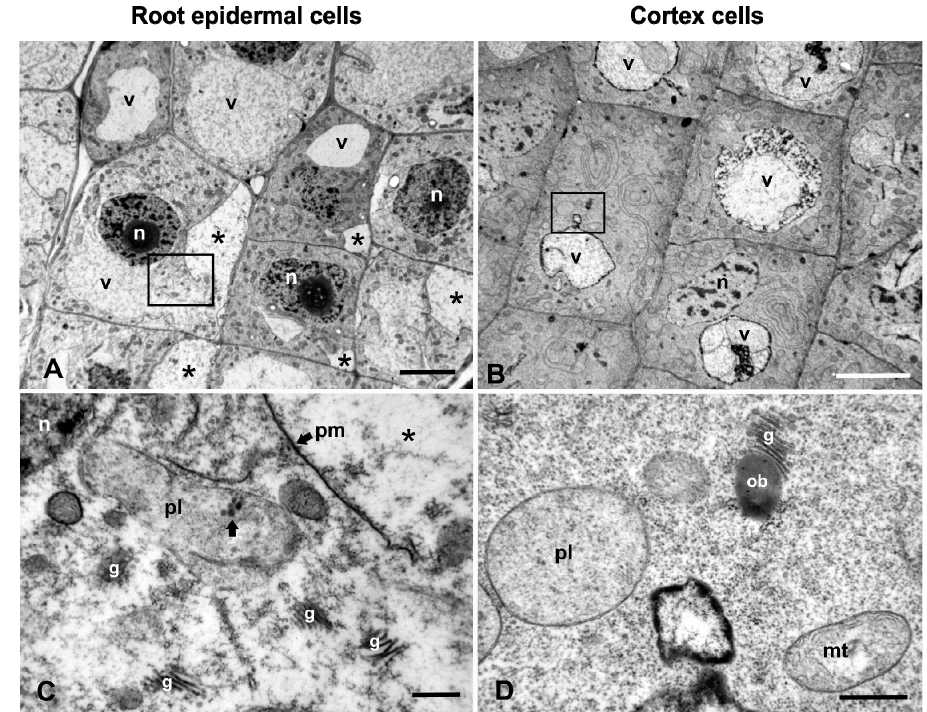
Figure 5. Comparative micrographs of epidermal and cortex cells in the meristematic zone of P. sativum roots treated with 200 mg/L W for 24 h. ( A , B ). General views showing many detachments of the plasma membrane in the epidermal cells ( A , asterisks), but not in the cortex cells ( B ). Vacuoles (v) in both cases are atypical. ( C , D ). Higher magnification views of the outlined areas in ( A ) and ( B ), respectively, showing severe disintegration of plastids (pl) and Golgi bodies (g) in the epidermal cell ( C ), but less degraded in the cortex cell ( D ). n = nucleus, ob = oil body, pm = plasma membrane. Scale bars: A, B = 5 μ M; C, D = 0.5 μ M.